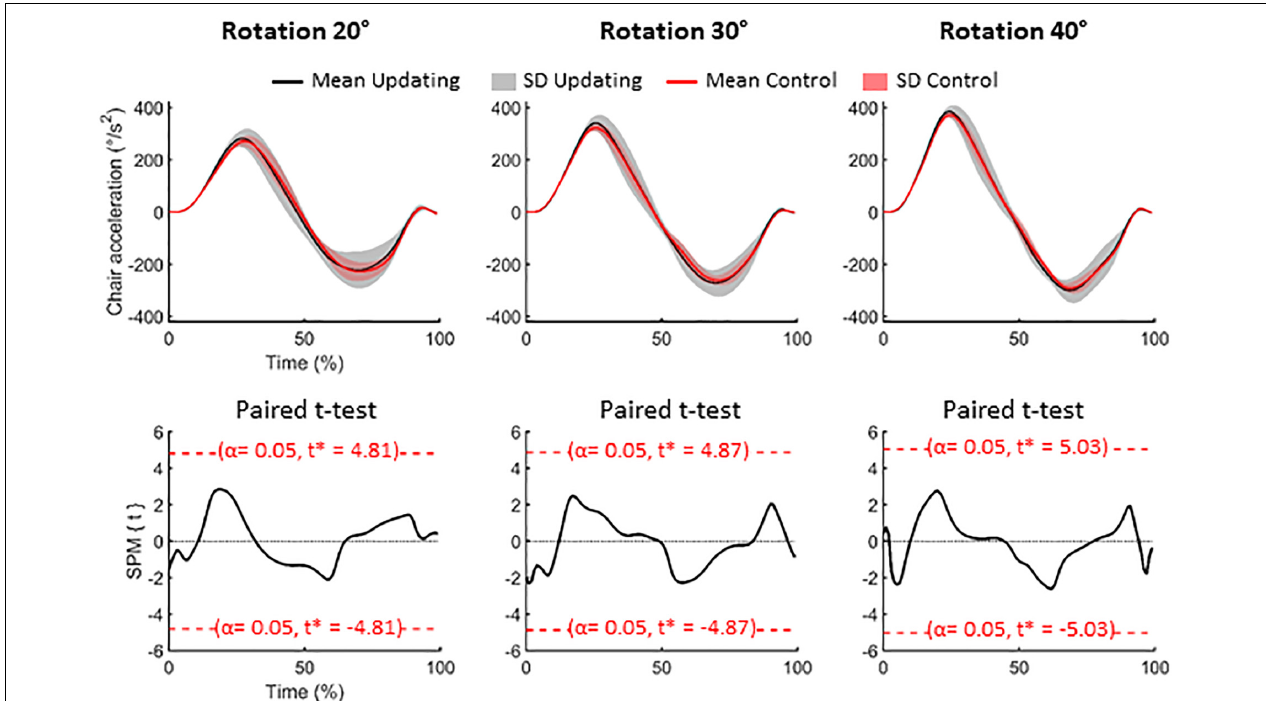
FIGURE 2 | Data related to the chair rotations. Upper panels: mean (solid lines) and standard deviation (SD, areas) of the acceleration of the chair for the 20 ◦ (left), 30 ◦ (middle) and 40 ◦ (right) rotation amplitude. Black time-series depict the group-mean for the Updating condition while the red time-series illustrate the group-mean for the Control condition. Lower panels: results of the paired t -test for each rotational amplitude. SPM{t} represents the temporal trajectory of the t statistic (black lines) and the critical threshold (red lines, α = 0.05). T -score for each comparison is illustrated in each panel.